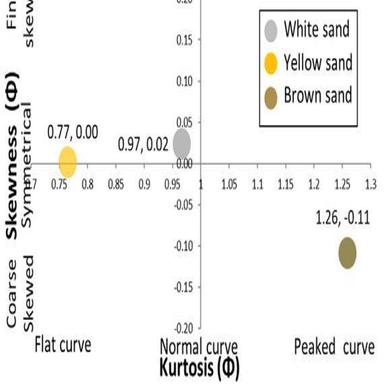
Mean vs. Sorting values. Fig. 6. Skewness vs. kurtosis values.